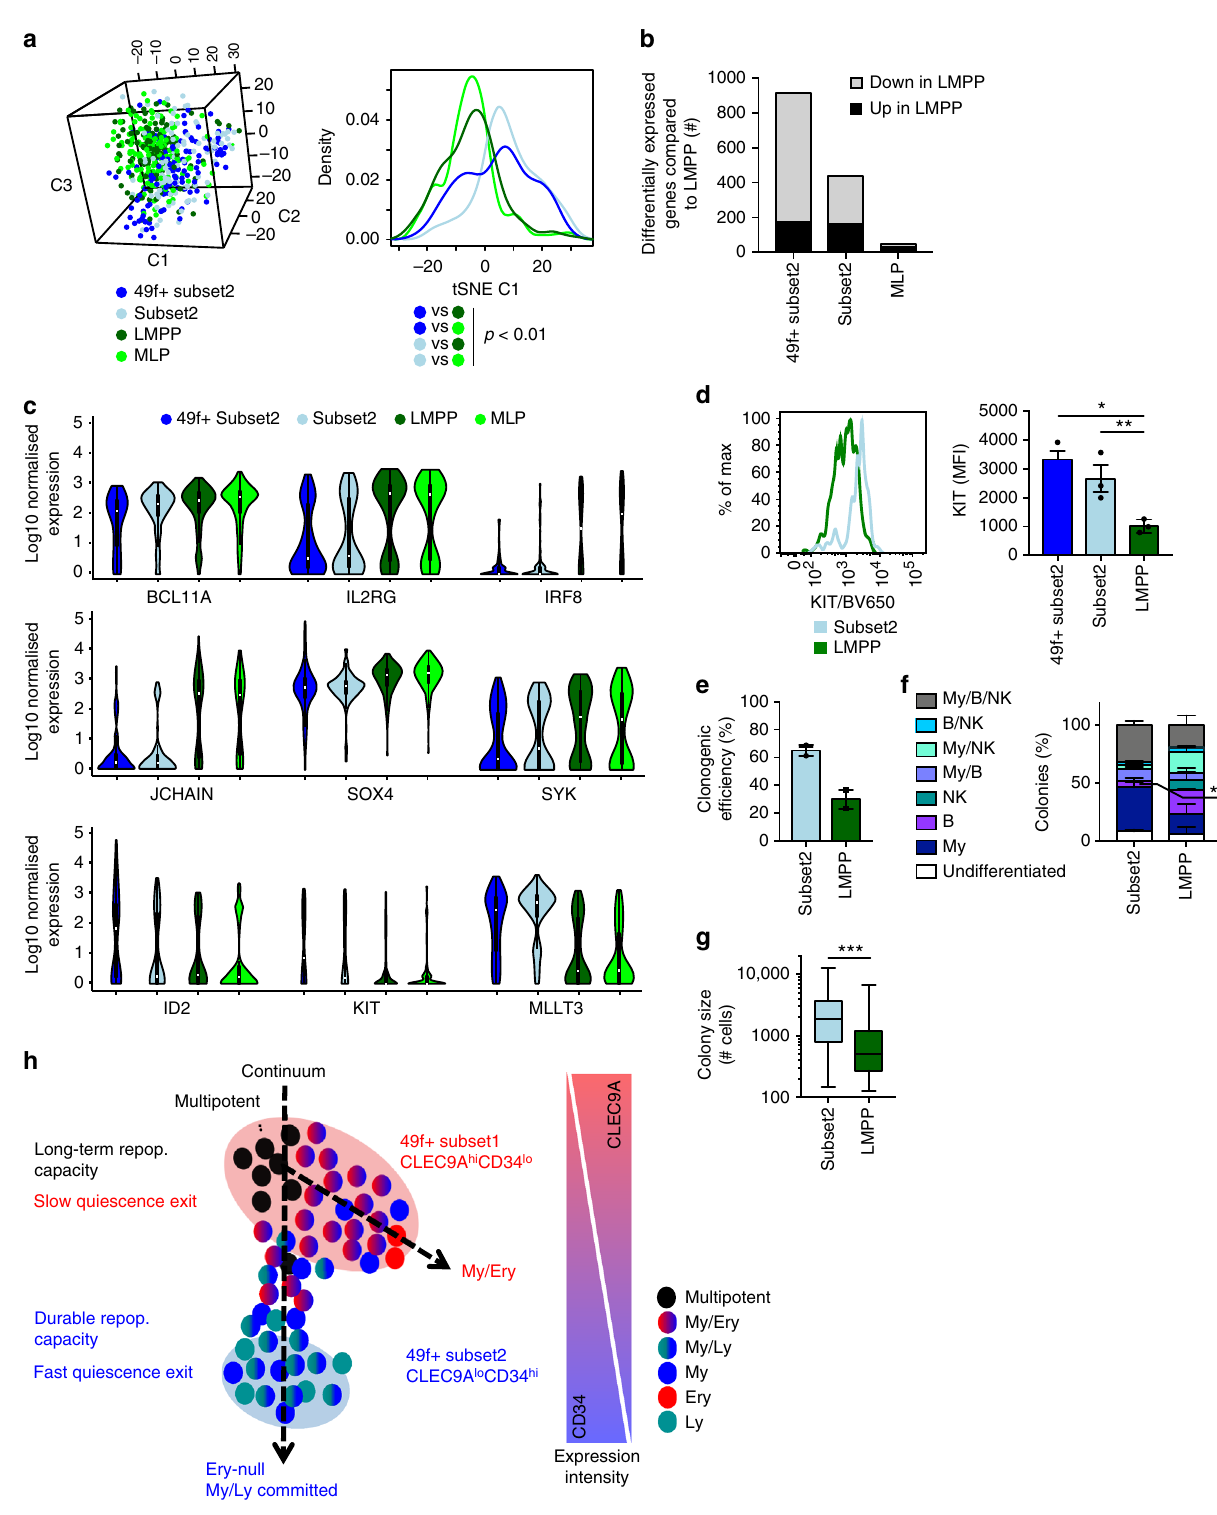
related to Ly-priming, including the BCL11A and SOX4 tran- levels of KIT protein, as well as those of other stem cell associated scription factors required for differentiation of MLPs to B cells 32 , cell surface markers (Supplementary Fig. 7b – d), were also found are gradually and signi fi cantly upregulated progressing from 49f + to be signi fi cantly downregulated in LMPPs compared to 49f + Subset2 to Subset2 to LMPP to MLP (Fig. 6c). In parallel, genes Subset2 and Subset2 cells (Fig. 6d). Finally, when the differ- involved in the maintenance of HSC self-renewal ( ID2 46 ) and entiation capacity of 240 Subset2 and 240 LMPP single cells along the My and Ly branches was tested in vitro, we observed that engraftment capacity ( KIT 34 ) are signi fi cantly and progressively phenotypic Subset2 single cells had higher clonogenic ef fi ciency downregulated from 49f + Subset2 to LMPPs/MLPs. Cell surface NATURE COMMUNICATIONS| (2018) 9:4100 |DOI: